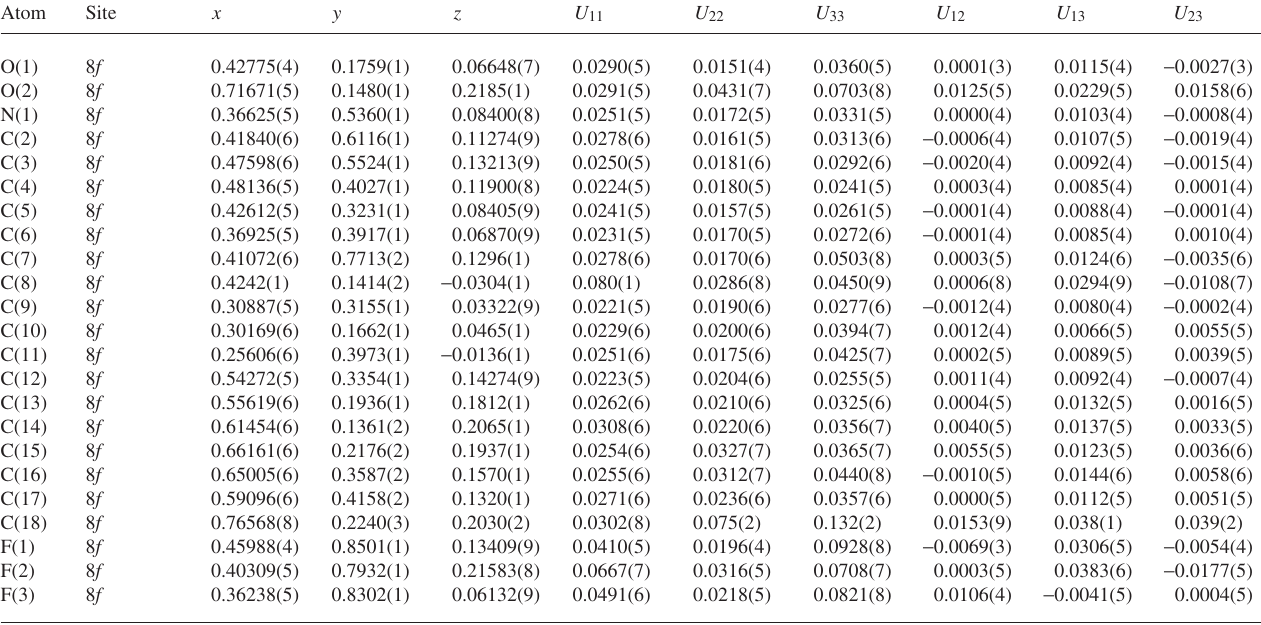
Table 3. Atomic coordinates and displacement parameters (in Å 2 )